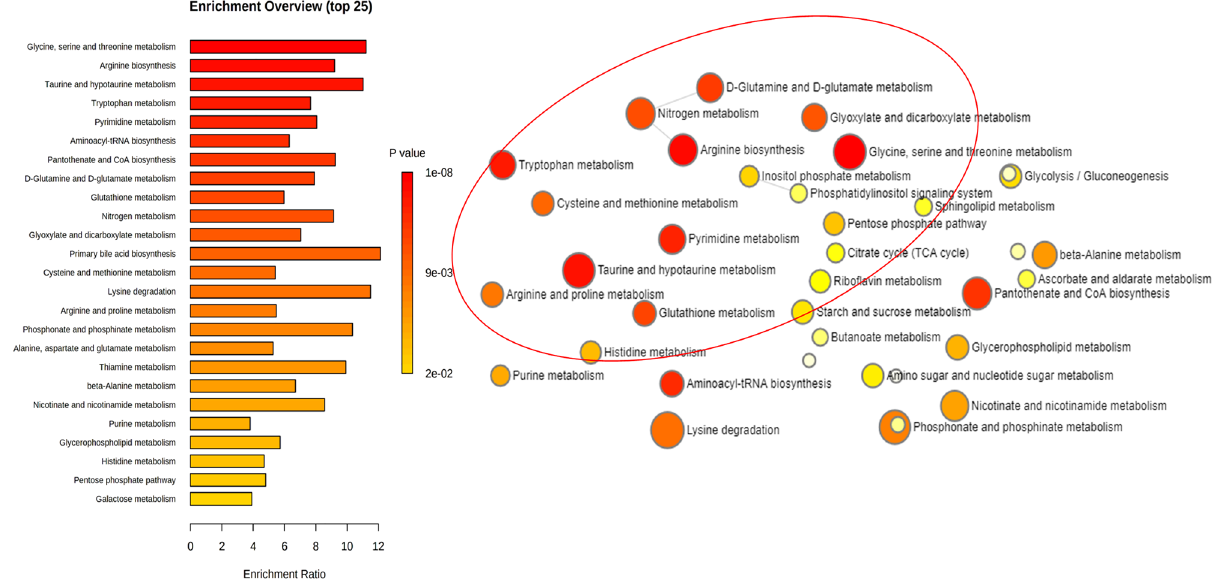
Figure 4. Pathway enrichment analysis of untargeted metabolomics. Significant alteration in leukocyte IgGm + on amino acid metabolism, especially pathways involved in glycine serine threonine metabolism, arginine biosynthesis, and tryptophan metabolism.